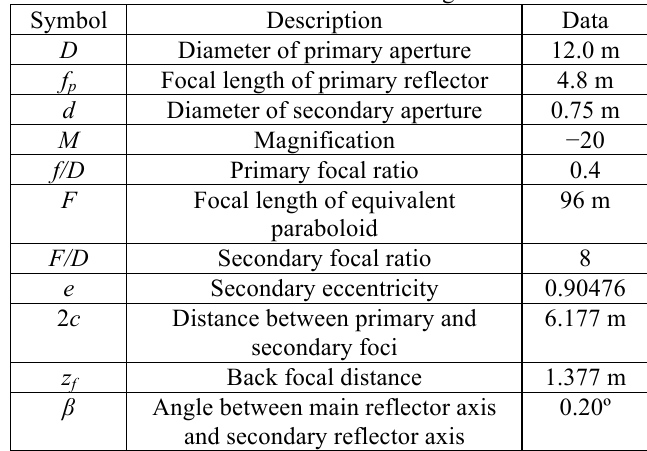
Table 4: Parameters for the offset Gregorian antenna.